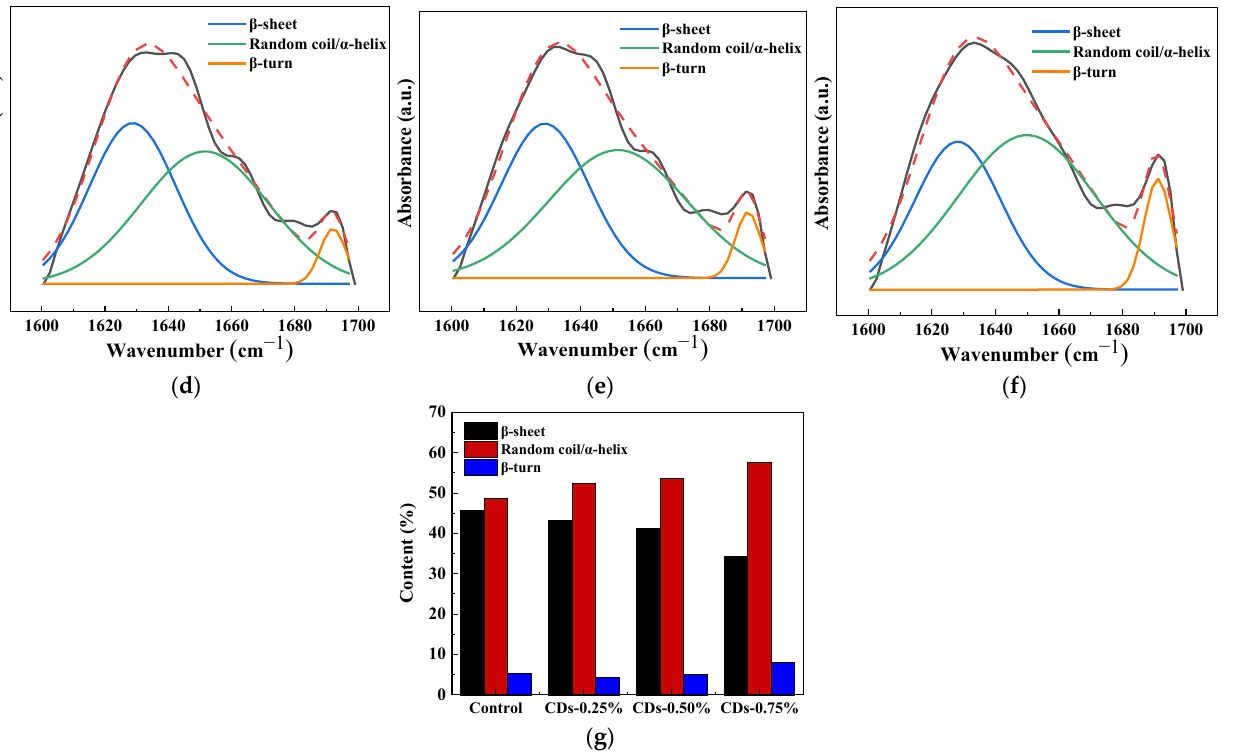
Figure 9. Effect of CDs on the mechanical properties of silk fiber. ( a ) Stress–strain curves of silk fiber; ( b ) FT-IR spectra of silk fibroin fiber; the deconvolution of FT-IR spectra in the amide I bands of ( c ) control, ( d ) CDs-0.25%, ( e ) CDs-0.50% and ( f ) CDs-0.75%. ( g ) Contents of secondary structures obtained based on the amide I bands in FT-IR spectra.